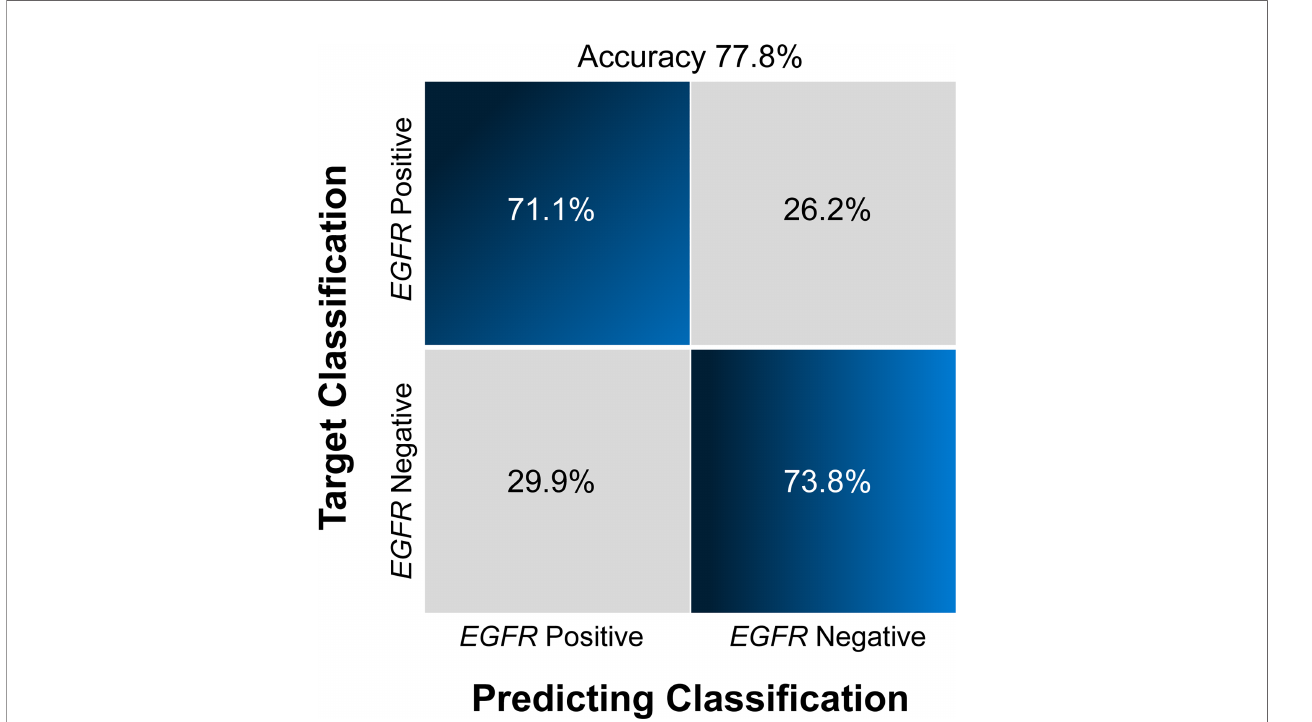
FIGURE 4 | Confusion matrix (A) and ROCs (B) for the classi fi cation of EGFR mutation status in the test set The confusion matrix was generated using a combined model. The combined model appeared to achieve a higher AUC than any individual sequence, but the differences were not statistically signi fi cant. EGFR , epidermal growth factor receptor; ROC, receiver operating characteristics curve; AUC, area under the curve; T1CE, contrast-enhanced T1-weighted imaging; T2-FLAIR, T2 fl uid-attenuated inversion recovery; T2WI, T2-weighted imaging; combination, combined model extracting features from the three